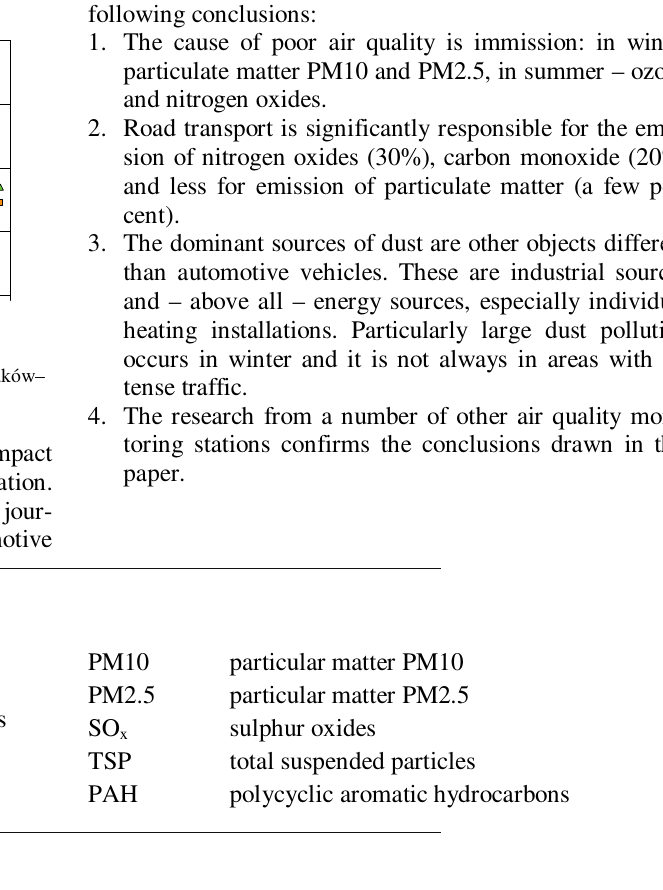
Fig. 13. The immission of nitrogen oxides on 8 June 2016